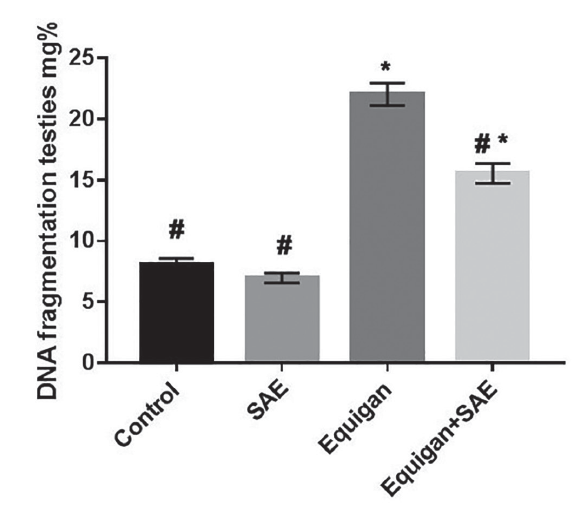
FIGURE 4 - DNA fragmentation in testicular tissues in the different groups under study. (Significant difference from the control group at *p < 0.05; Significant difference from Equigan group at #p <